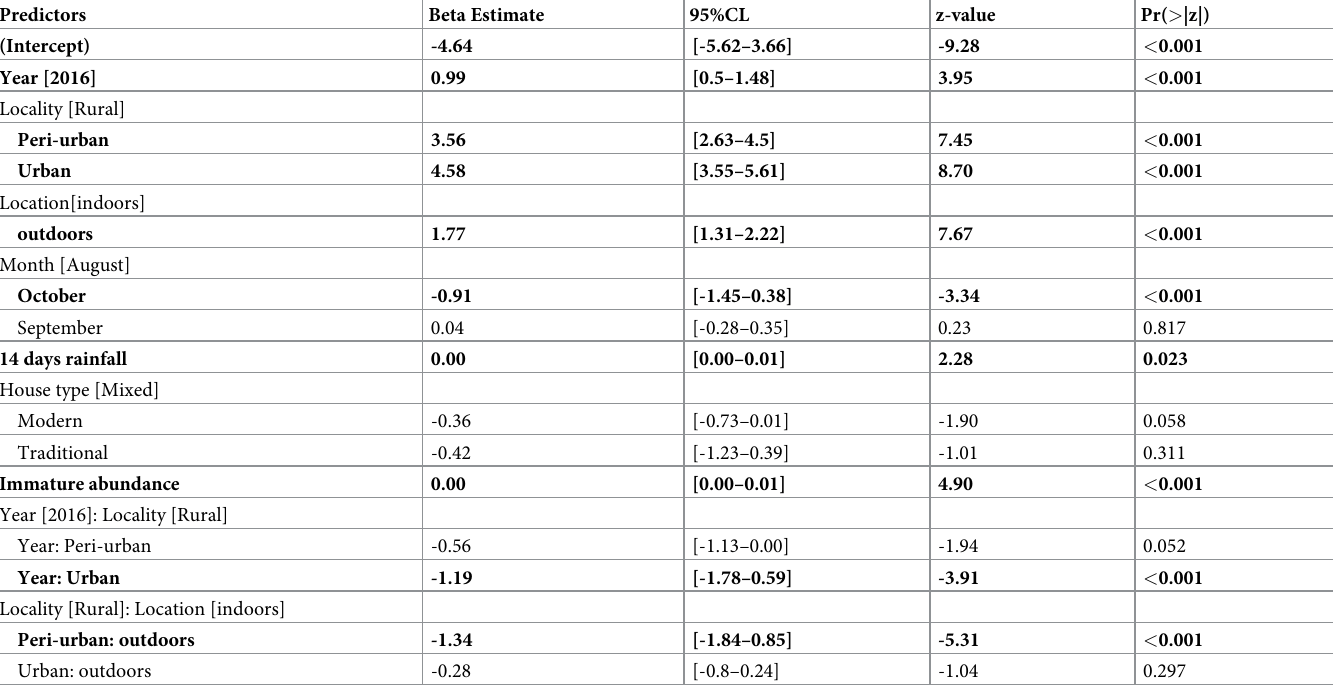
Table 3. Aedes aegypti adult model glmm showing predictors beta estimates of effect size. Confidence intervals, test statistic (z-value) and associated probability for the minimal model. Significant predictors are highlighted in bold text , and non-significant terms, not included in the model are listed on the bottom